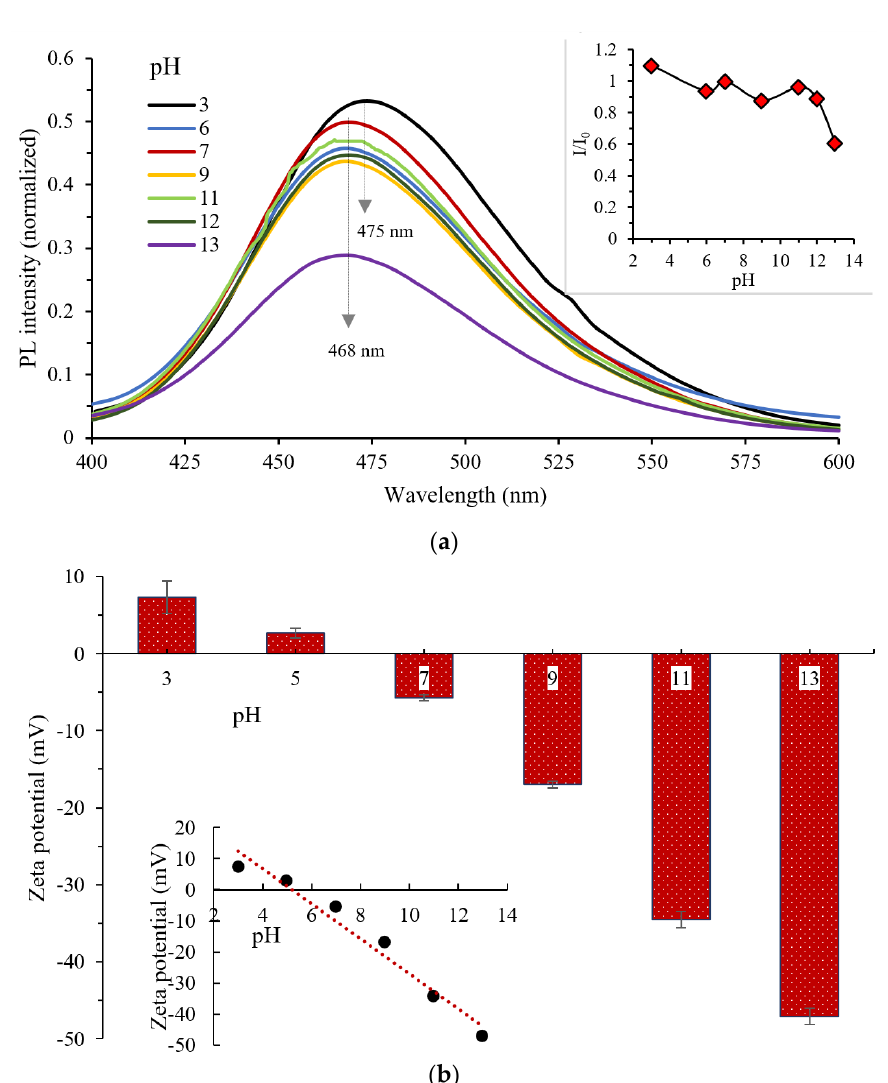
Figure 5. ( a ) The emission dependence of N–CDs on pH values with λ ex = 350 nm and ( b ) zeta potential study of N–CDs at various pH values. Inset: ( a ) the effect of different pH values on the relative intensity and ( b ) the linear relationship between pH and zeta potential.